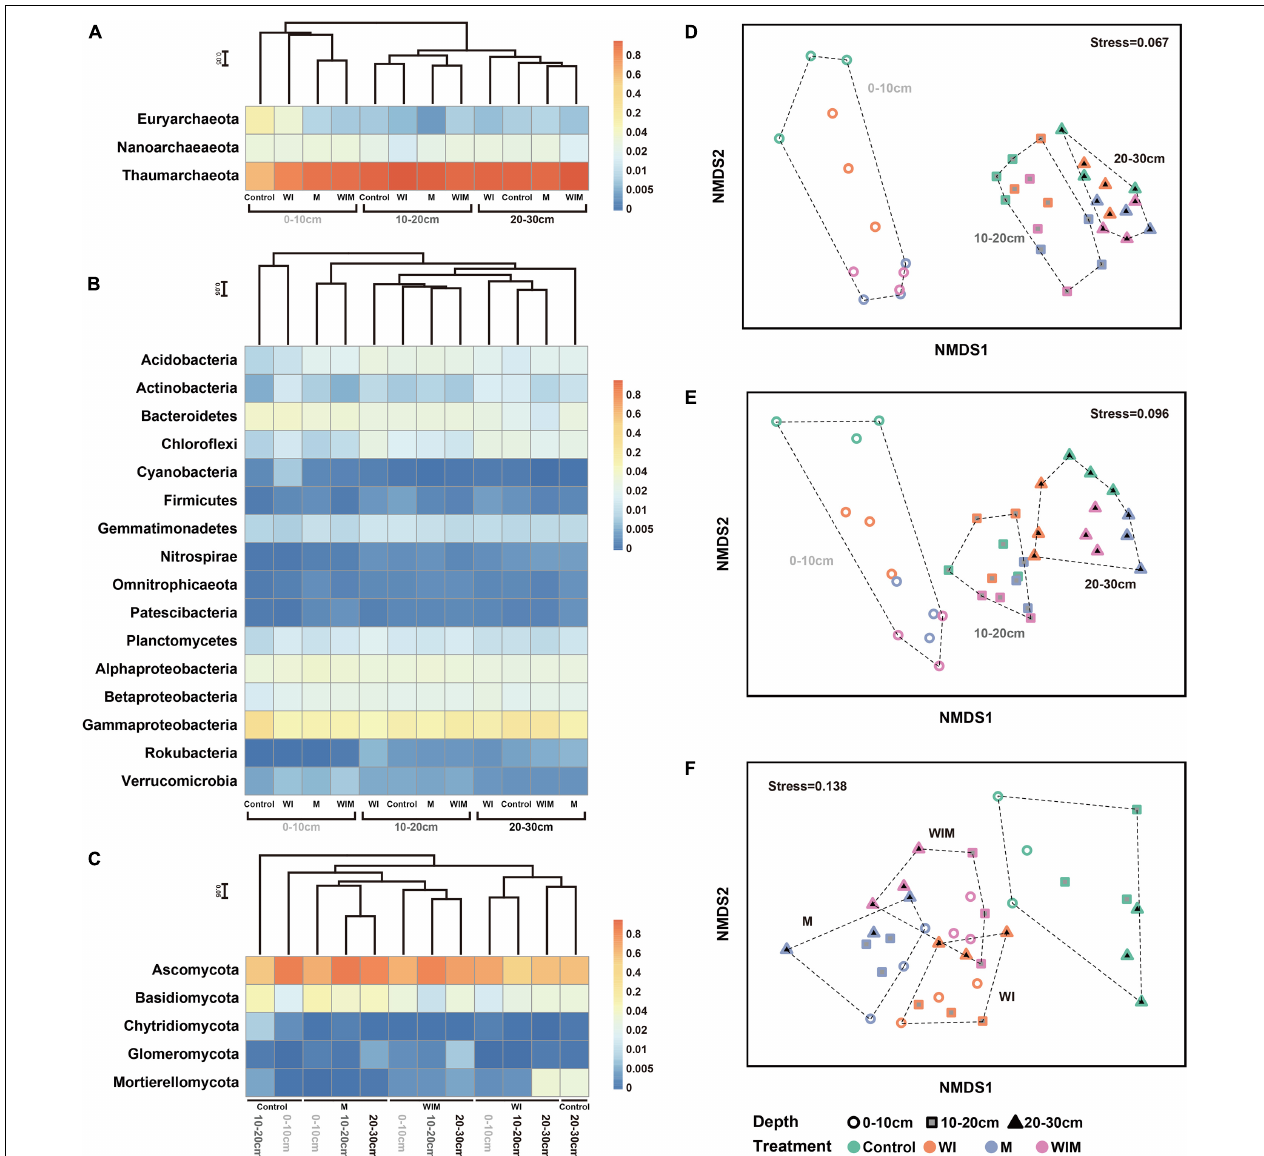
FIGURE 1 | Heatmap showing the dominant phyla of soil archaea (A) , bacteria (class for Proteobacteria) (B) and fungi (C) under different treatments. Non-metric multidimensional scaling (NMDS) ordination of soil archaeal (D) , bacterial (E) , and fungal (F) communities. Both the cluster dendrogram and NMDS were generated based on Bray–Curtis distance. WI, freezing saline water irrigation; M, plastic mulching; WIM, WI +